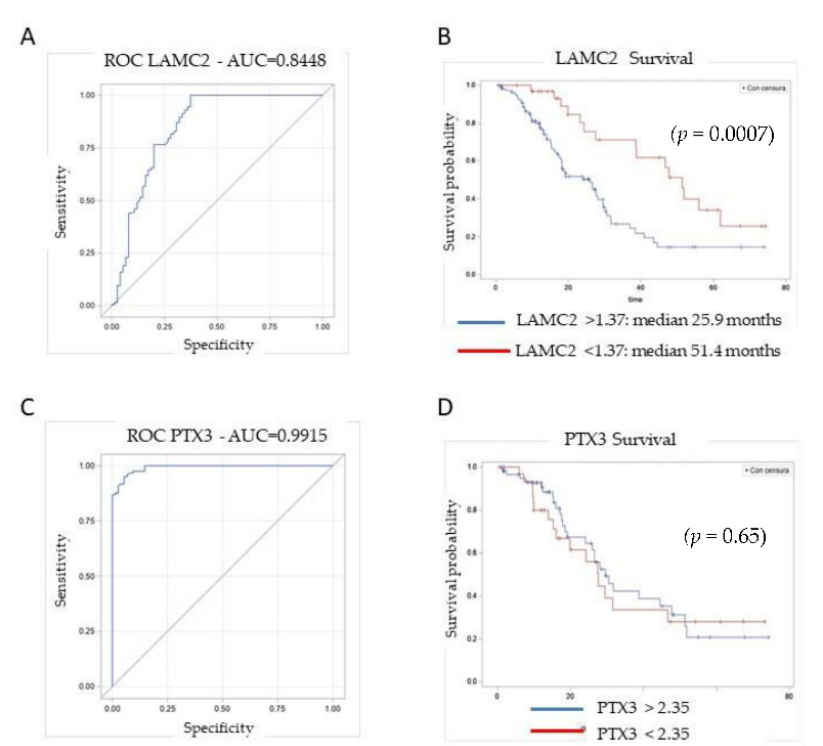
Figure 4. Sensitivity and specificity of ( A ) LAMC2 and ( B ) PTX3, analyzed by the Area Under the Curve (AUC) of the Receiver Operating Characteristics (ROC) curves. Analyses include PDAC patients ( n = 200) and healthy individuals ( n = 75). Association of biomarker levels of ( C ) LAMC2 and ( D ) PTX3 with patient survival rate, considering 148 effectively resected PDAC patients (52 were considered non-resectable at the time of surgery). PDAC patients with circulating levels of LAMC2 <1.37 ng/mL had a significantly longer median survival time of 51.4 months compared to patients with LAMC2 >1.37 ng/mL, which had a median survival time of 25.9 months. Statistical analysis: Kaplan–Meier method ( p = 0.0007). For PTX3, with a threshold value of 2.35 ng/mL, the survival curves of patients with high or low PTX3 levels were not significant ( p = 0.84).